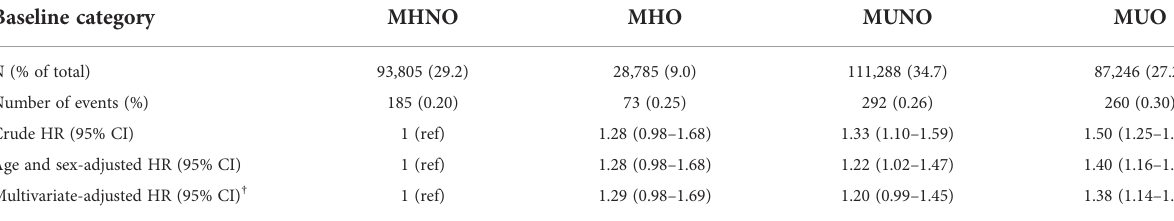
TABLE 2 Risk of incident kidney cancer according to baseline metabolic health and obesity status. Baseline